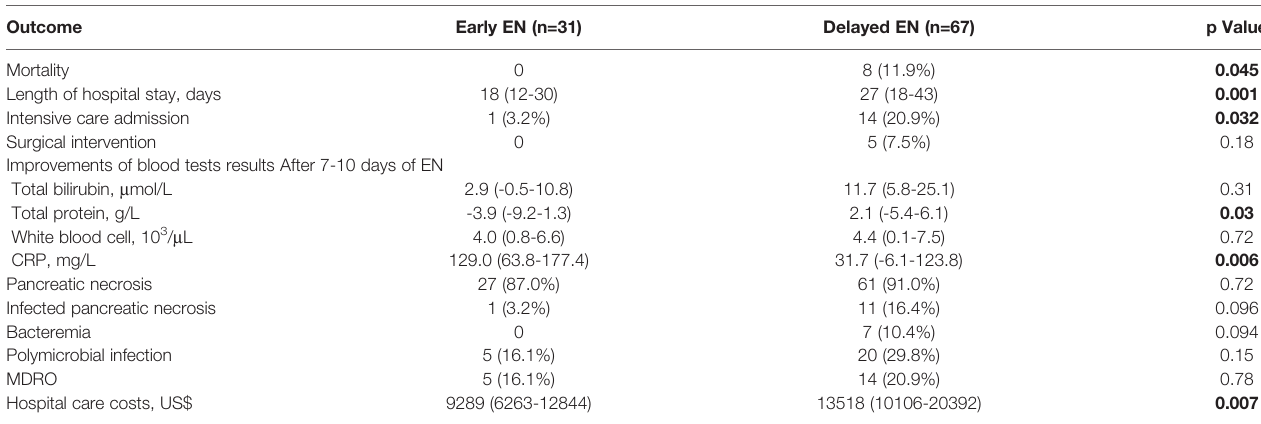
TABLE 2 | Clinical Outcomes.